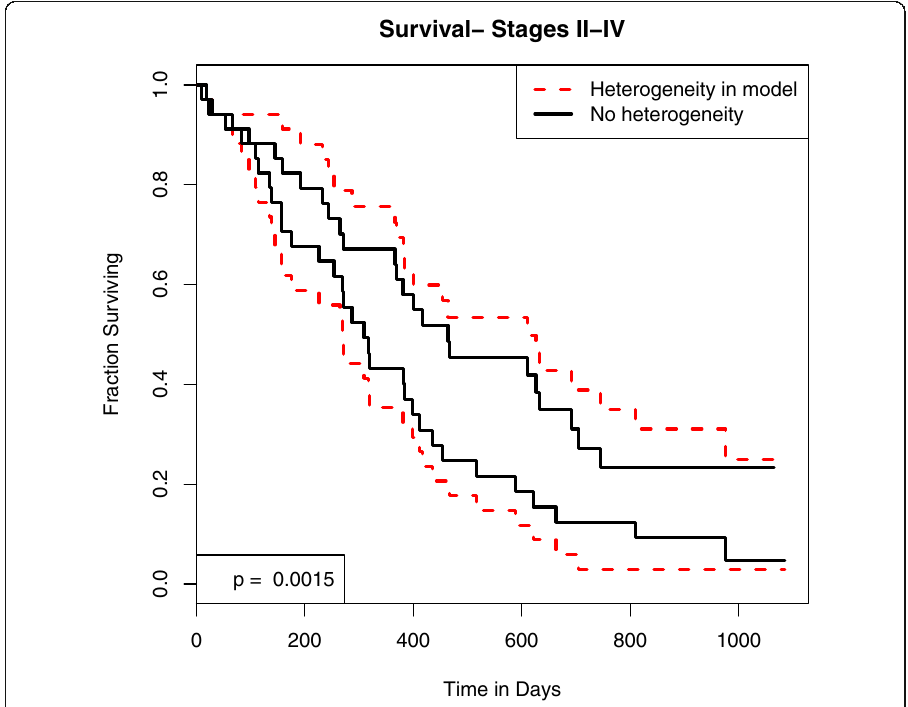
Fig. 2 Kaplan-Meier survival curves for Stage II-IV patients with risk (above and below median) as defined by the multivariable model - see Table 2. The black curves do not use Heterogeneity as a risk factor, the red ones do. The p -value in the lower left evaluates (via a likelihood ratio analysis) the significance of the improved separation between the low and high risk groups when the Heterogeneity information is included